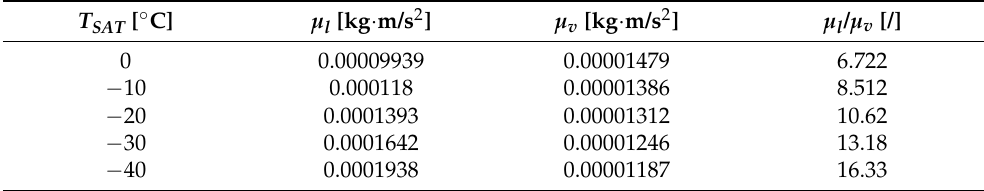
Figure 13. Variation in experimental pressure drop according to different saturation temperatures at constant heat and mass fluxes (200 kg/(m 2 ·s) and 20 kW/m 2 ). Table 9. Variation in properties (liquid viscosity, vapor viscosity, and viscosity ratio) with respect to different saturation temperatures.